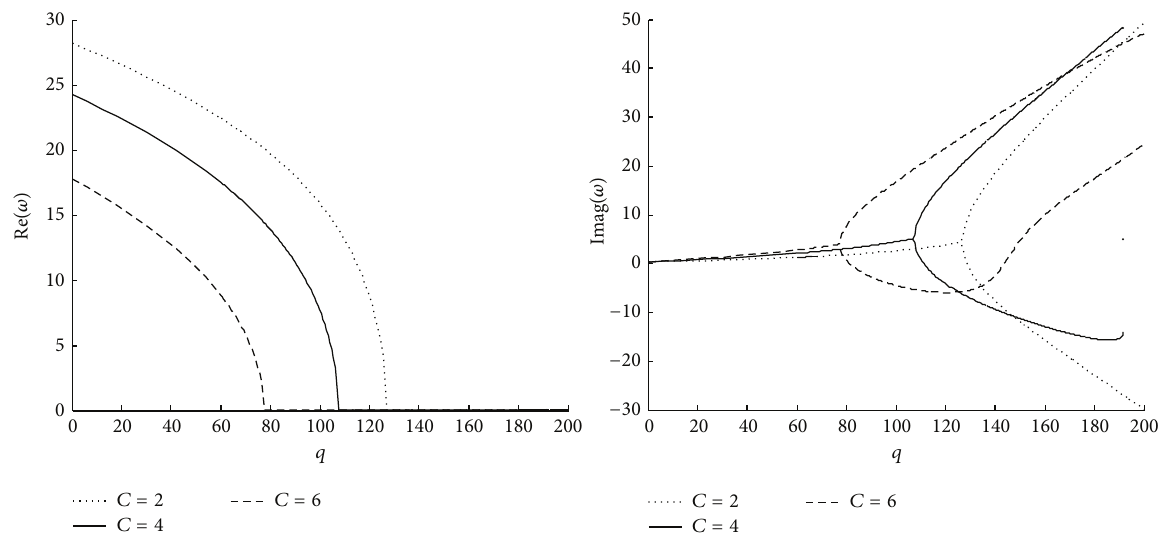
Figure 6: The first-order dimensionless complex frequencies versus dimensionless follower force 𝑞 ( 𝐻 = 10 −3 , 𝑟 = 1 , 𝑈 = 20 , and 𝜆 = 0.05